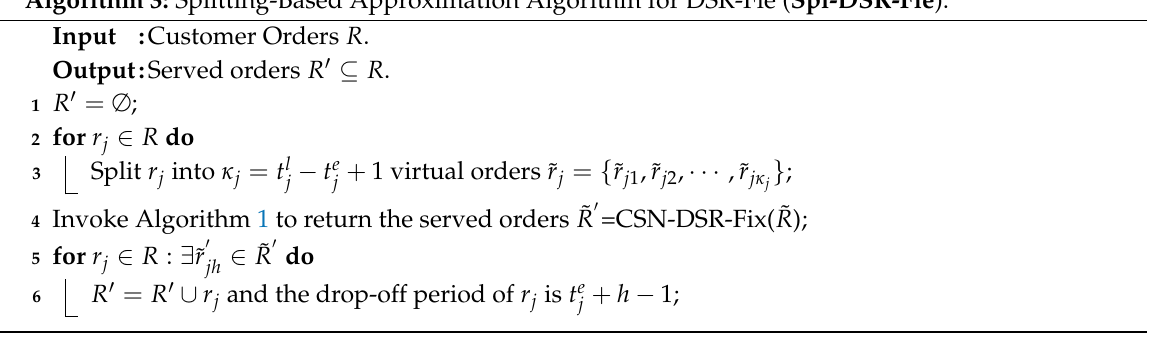
Algorithm 3: Splitting-Based Approximation Algorithm for DSR-Fle ( Spl-DSR-Fle ). Input : Customer Orders R